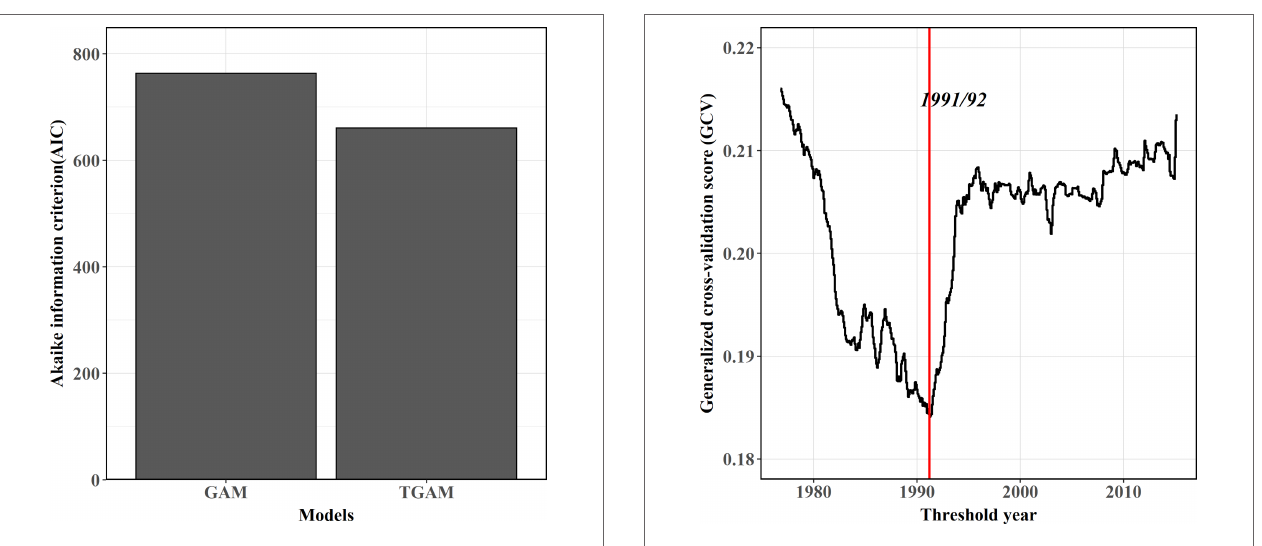
FIGURE 7 | Generalized cross-validation score (GCV) paths of the best fitted models by TGAM. The red line represents the threshold year characterized by concave GCV paths